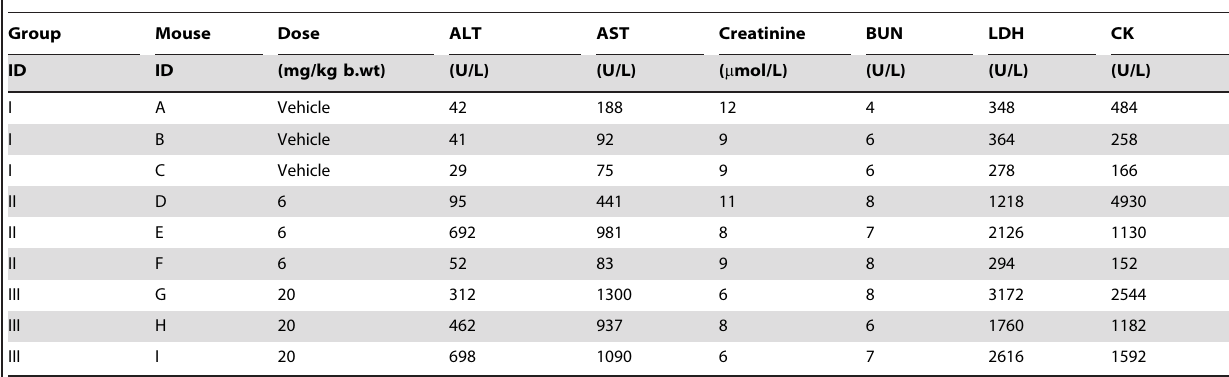
Table 1. Blood clinical chemistry analysis for each